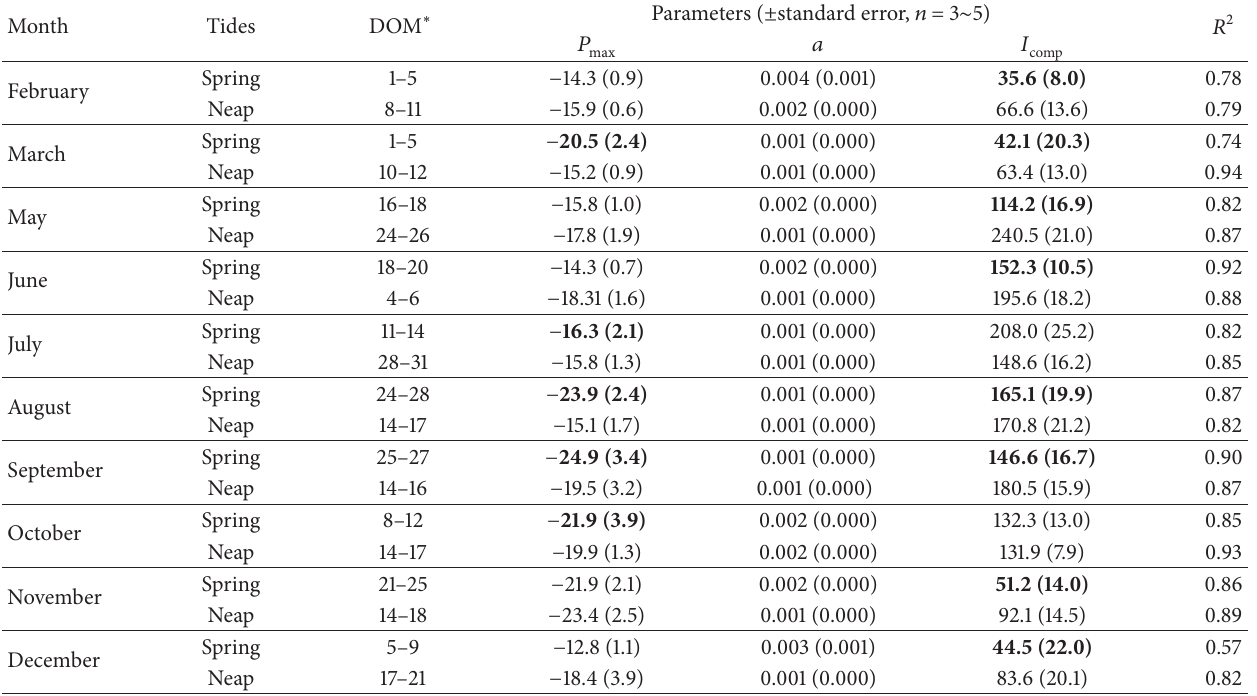
Table 1: Parameters and 𝑅 2 values using the Landsberg model (see (2) in the text) fitted to the daytime net ecosystem change of CO based on photosynthetic active radiation (PAR) in 10 months of the year 2010 for the mangrove forest of Zhangjiangkou, Yunxiao, Fujian